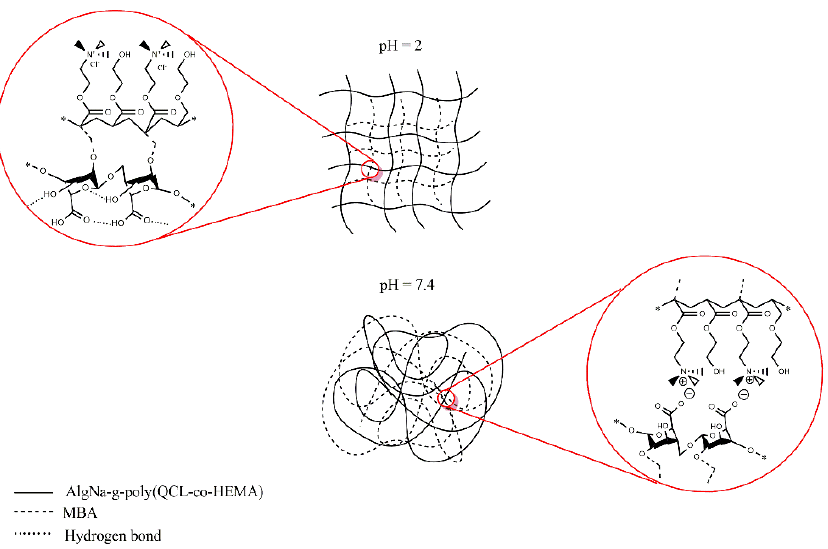
Figure 5. Schematic representation of the interactions between functional groups in the polymeric network chains at pH 2.0 and pH 7.4.